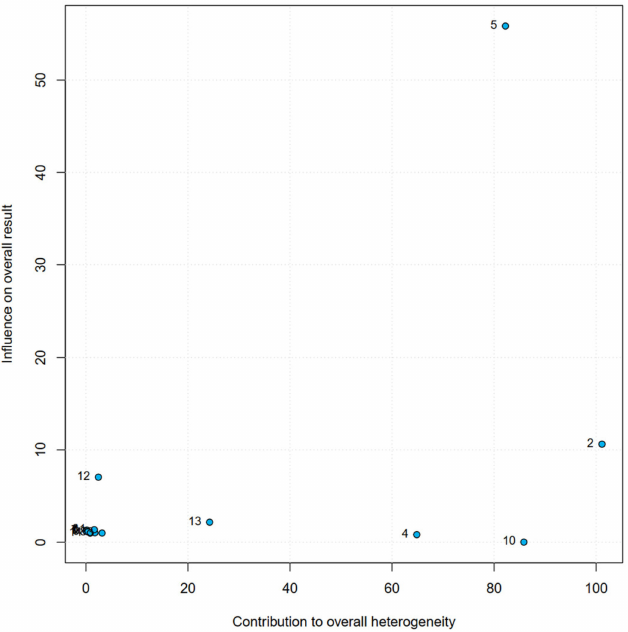
Figure 4. Baujat plot. Published data from 1 (Adam et al. [27]), 2 (Batieha et al. [25]), 3 (Bencaiova et al. [26]), 4 (Drukker et al. [10]), 5 (Levy et al. [6]), 6 (Mahmood et al. [28]), 7 (Mal- hotra et al. [19]), 8 (Masukume et al. [8]), 9 (Mehedi et al. [20]), 10 (Nair et al. [24]), 11 (Patel et al. [9]), 12 (Orlandini et al. [21]), 13 (Tandu-Umba et al. [22]) and 14 (Van Bogaert et al. [23]) were used to calculate the pooled OR and